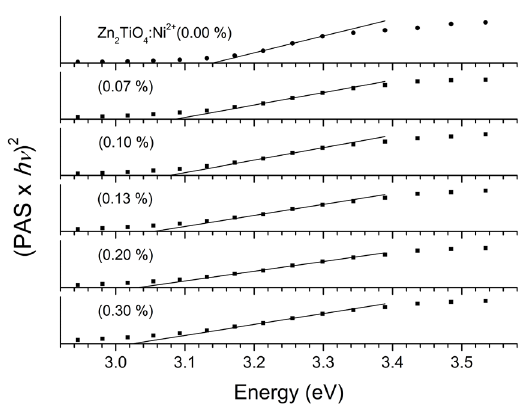
Figure 4. (PAS× hv ) 2 data (black dots) against the energy of the absorbed photon, for Zn Ni TiO , where x = 0.00, 0.0007, 2(1-x) 2x 4 0.001, 0.0013, 0.002 and 0.003. The energy of the absorption transitions were plotted on the horizontal axis. The lines positions on the horizontal axis indicate the bandgap energy of the samples.